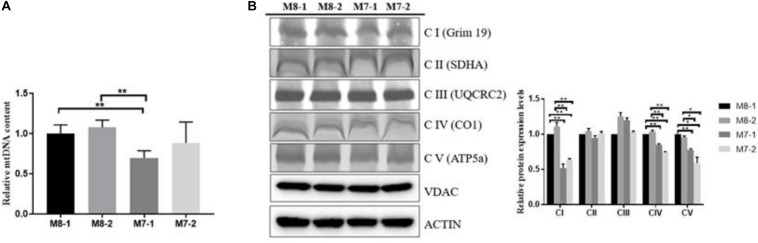
M7 cybrids exhibit decreased respiratory chain complex (RCC) amount relative to M8 cybrids. (A) mtDNA content of M8 and M7 cybrids. Relative mtDNA content were normalized to M8-1 cybrid. (B) Whole-cell extract of mitochondrial respiratory complexes from M8 and M7 cybrids solubilized with dodecyl maltoside (DDM) at a ratio of 2.5 g of detergent/g protein and then subjected to blue native PAGE (BN- PAGE)/immunoblot (IB) analysis. Complexes I, II, III, IV, and V were immunoblotted with anti-Grim19, SDHA, UQCRC2, COX1, and ATP5a antibodies, respectively; VDAC was used as a total-protein loading control. Protein levels were normalized to M8-1 cybrid. Data are presented as the mean ± SD from at least 3 independent tests per experiment. **P < 0.01.